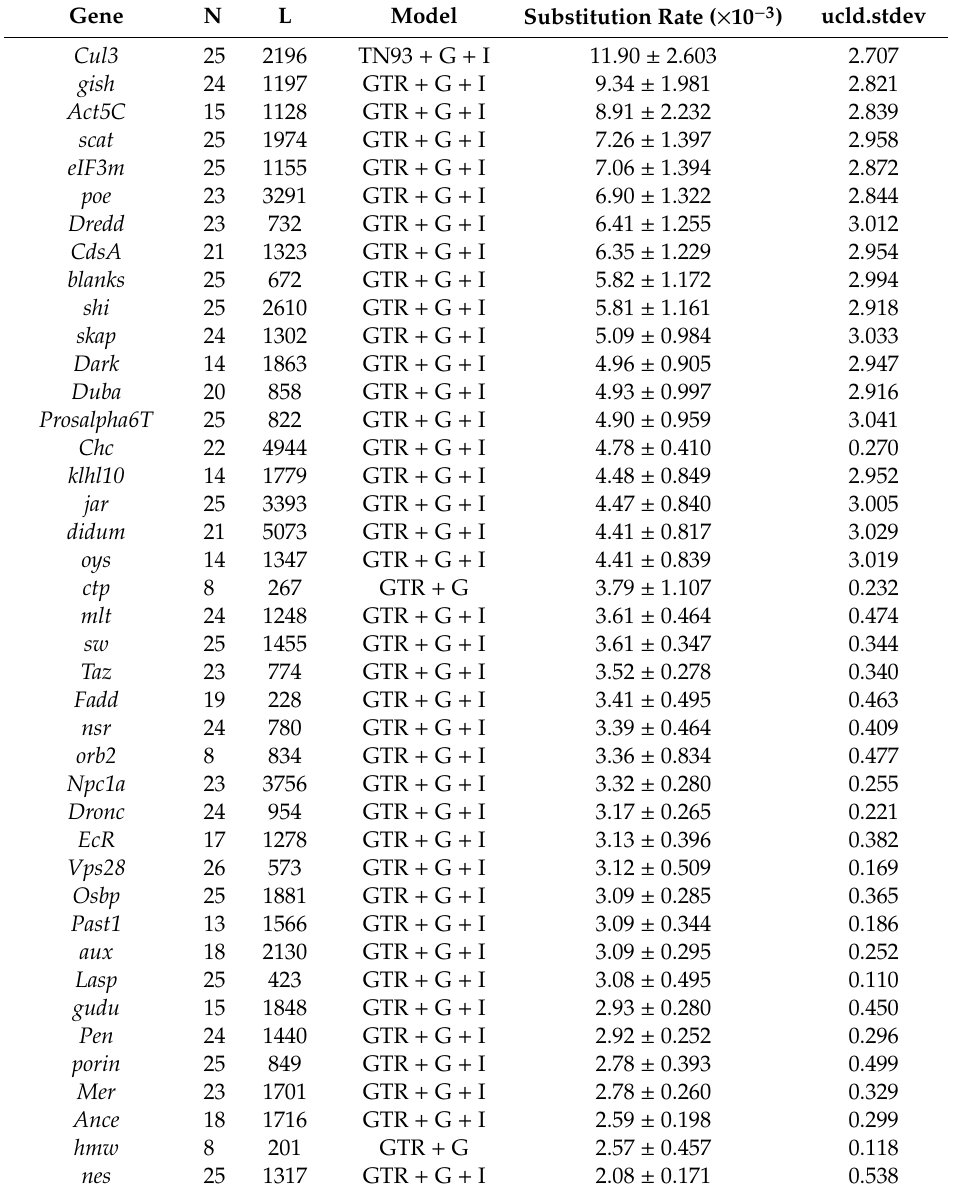
Table 5. Characteristics of the nucleotide phylogenetic data sets of sperm individualization genes in Coleoptera. The number of species (N), length of nucleotide sequence alignments (L), the determined evolutionary model, inferred evolutionary rates, and information on rate heterogeneity (ucld.stdev) are given for each